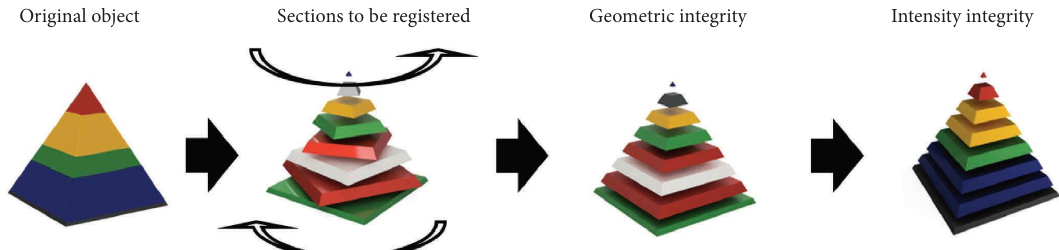
Figure 9: 3D-volume reconstruction based on subsequent image-to-image registration poses a challenge in the conservation of the geometric consistency of the sectioning tissue. In order to register a histological image with a scanned volume, the individual sections frst need to be aligned together, e.g., the volume needs to be reconstructed while geometrical consistency is maintained. Consecutive registration of individual slices needs to be performed until the original shape of the sectioned tissue is reconstructed in silico. Subsequently, in- consistencies in the intensity can be accounted